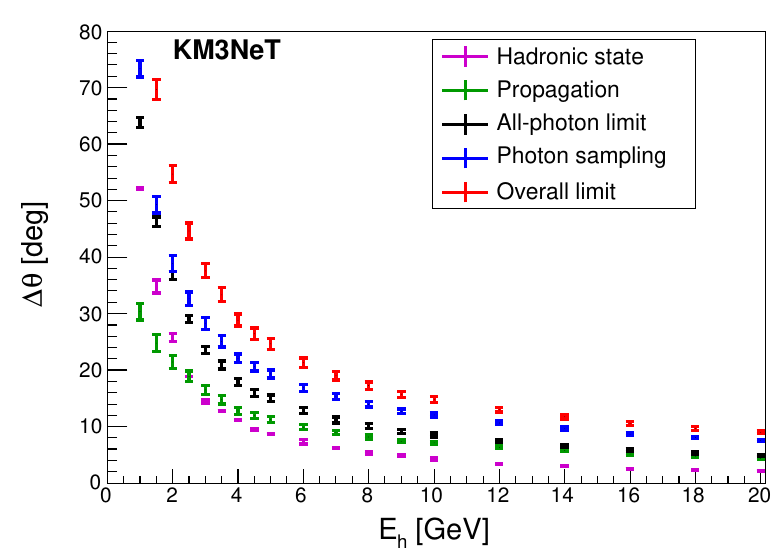
Figure 8 . Direction errors (cid:1) (cid:18) of hadronic cascades (68% quantiles). For explanations, see (cid:12)gure 5.